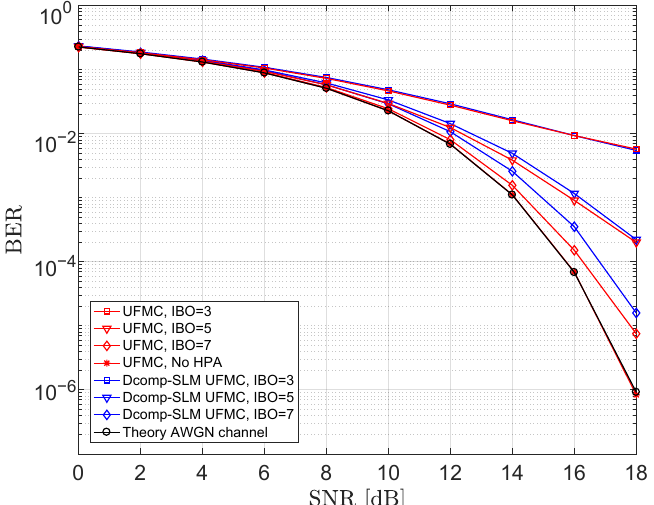
Figure 5. Bit error rate (BER) of the proposed Dcomp-SLM comparing to the original UFMC signal, in the presence of additive white Gaussian noise (AWGN) channel, for various input-back-off (IBO) levels at N = 512 and U = 6